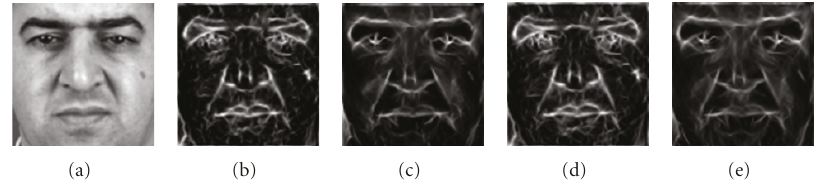
Figure 5: Examples of phase congruency images (from left to right): (a) the original face image, (b) the PCI for p = 3 and r = 6, (c) the PCI for p = 5 and r = 6, (d) and the PCI for p = 3 and r = 8, (e) the PCI for p = 5 and r = 8.